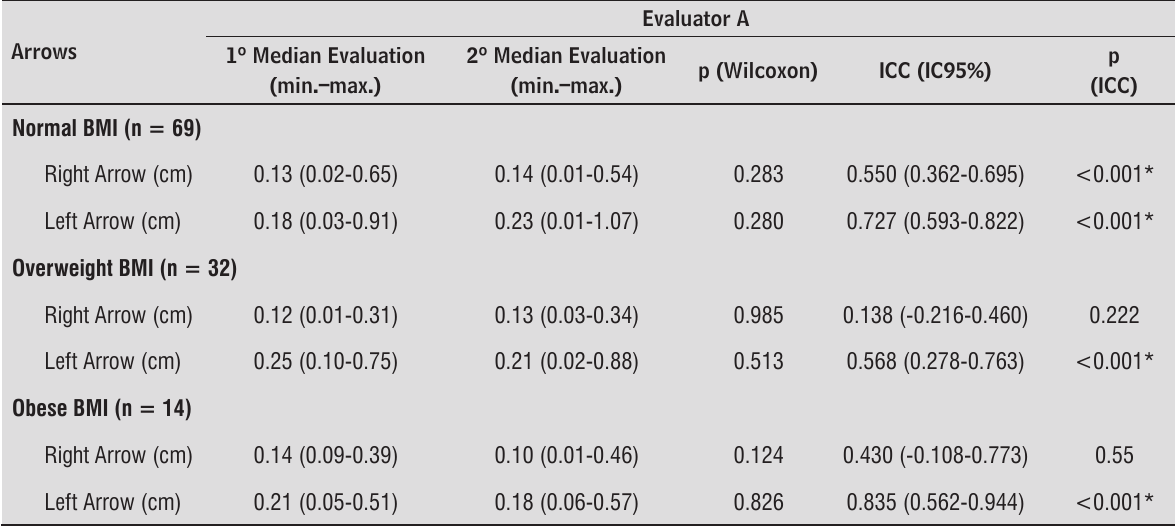
Table 1A - Results of the Vert 3D Version 1 regarding to the scoliosis arrows repeatability in the various nutritional profiles